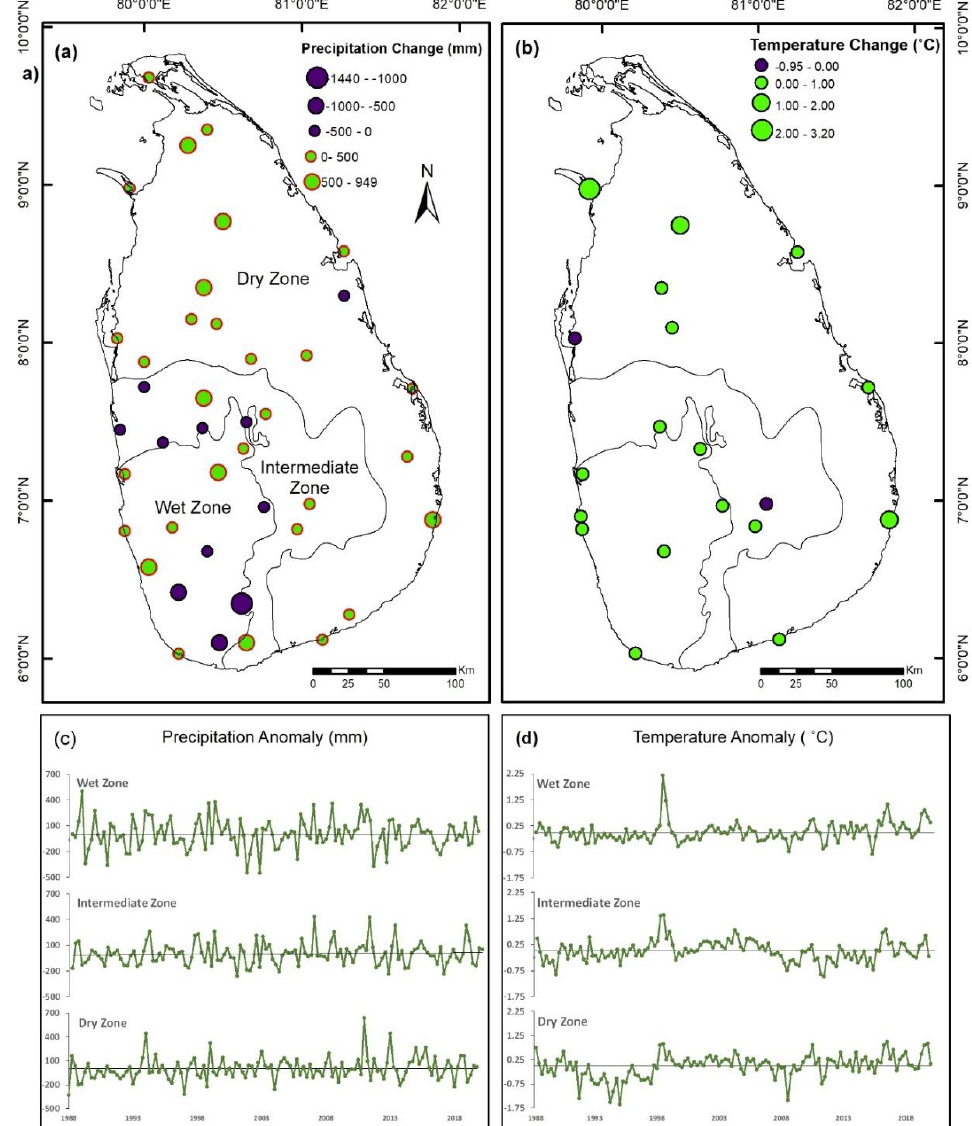
Figure 14. Primary drivers for surface water dynamics between 1988 and 2019. ( a ) Changes in precipitation from meteorological stations, ( b ) changes in temperature from meteorological stations.